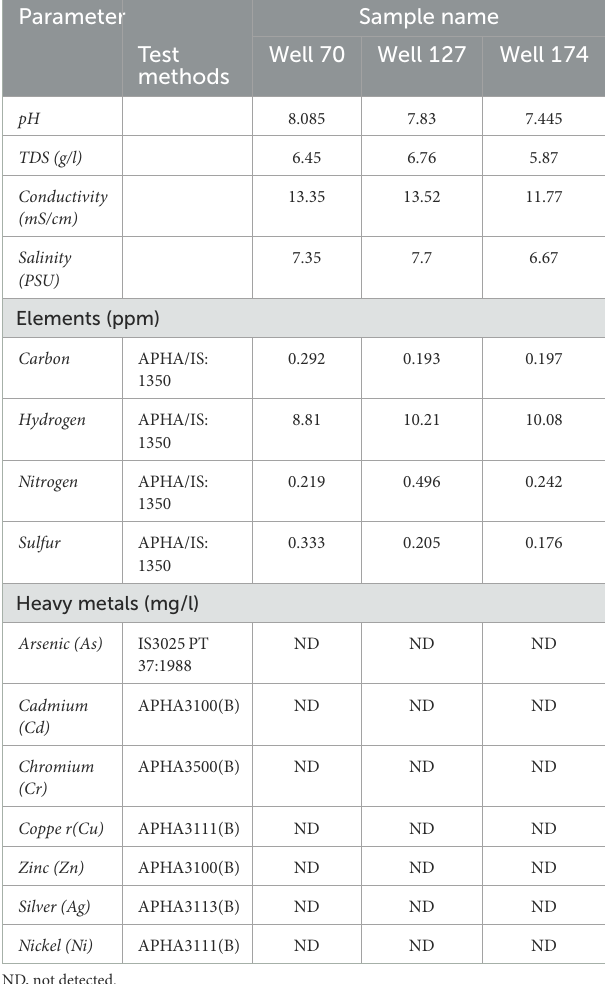
TABLE 2 Compositional analysis of oil collected from Bhagyam fields. S.